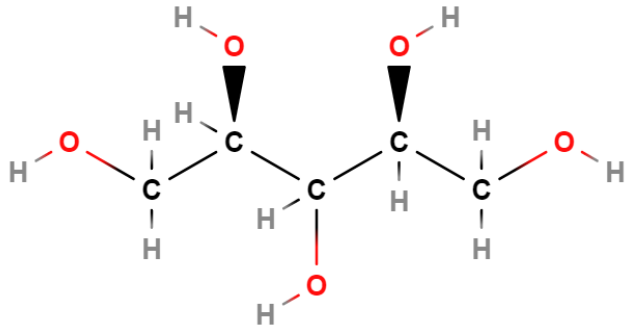
Figure 12. Structure of xylitol (C 5 H 12 O 5 ) .